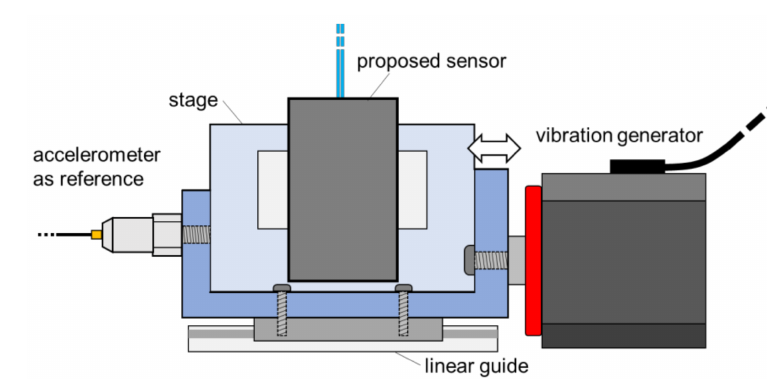
Figure 5. Experimental setup for frequency response characteristics of the proposed accelerometer.